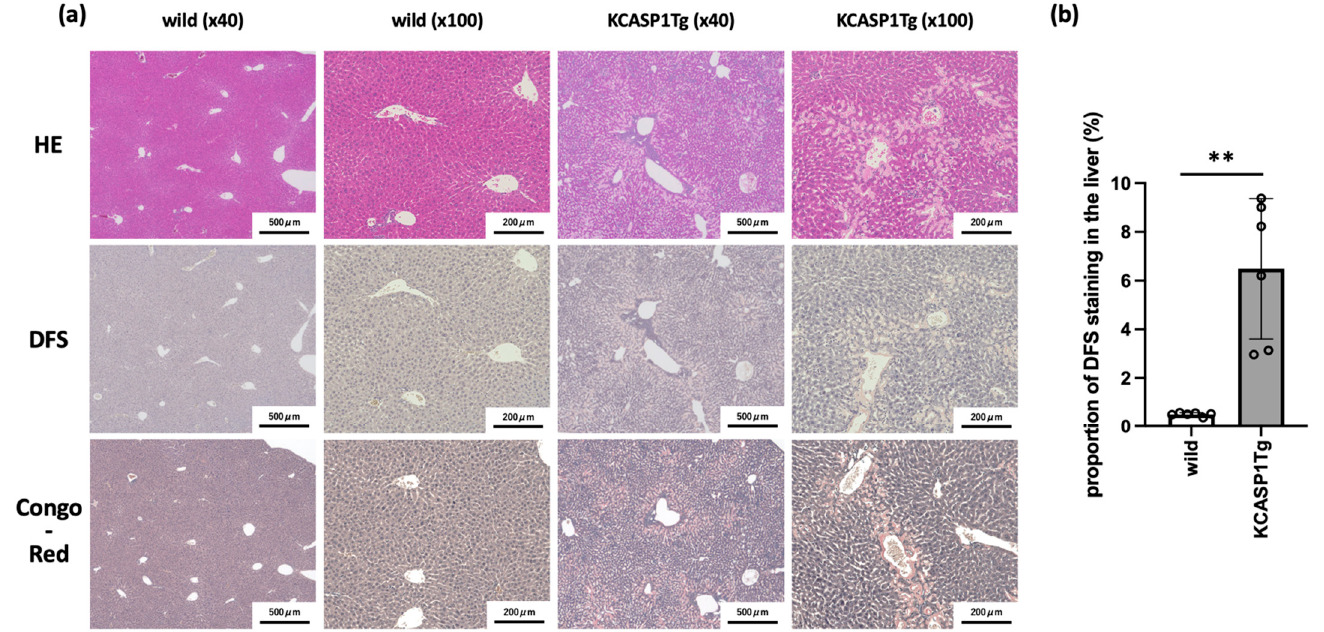
Figure 1. Histological analysis showed the amyloid deposition in the liver of KCASP1Tg mice. The liver was collected from 16-week-old KCASP1Tg (n = 6) and WT (n = 6) mice and stained with hematoxylin and eosin (H&E), direct fast scarlet (DFS), and Congo red. ( a ) Severe amyloid deposition was detected in the livers of KCASP1Tg mice compared to in WT mice. In particular, there were massive deposits radiating from the Glisson’s capsule, including the interlobular bile ducts, interlobular arteries, and interlobular veins, to the central veins of the liver. Images at ×40 and ×100 magnification are shown. The positive control of DFS staining is supplemented in Supplemental Figure S1. ( b ) DFS staining-positive area is quantified by Mann–Whitney test, and there was a significant increase in KCASP1Tg mice. The data is expressed as mean ± SD. ** p = 0.0022 between wild-type and KCASP1Tg mice.